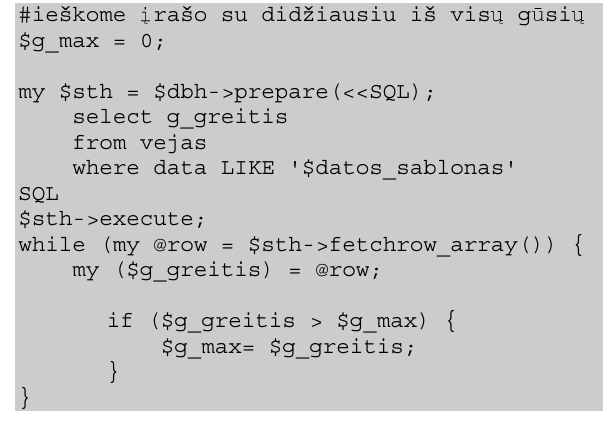
Fig 4 . Structural scheme of data warehouse